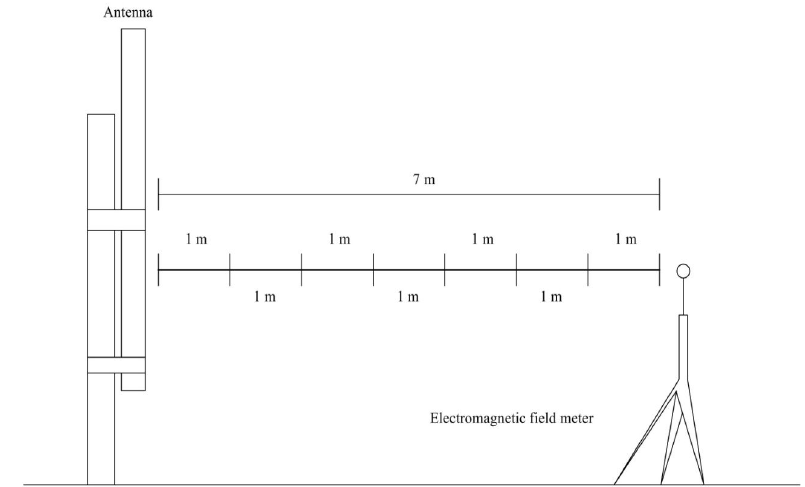
Figure 5. RF EMF power density measurement scheme for the mobile telephony base station antenna (ERP = 1329 W) (the measurement points correspond to different distances from the antenna’s vertical axis, located in the centre of the roof).